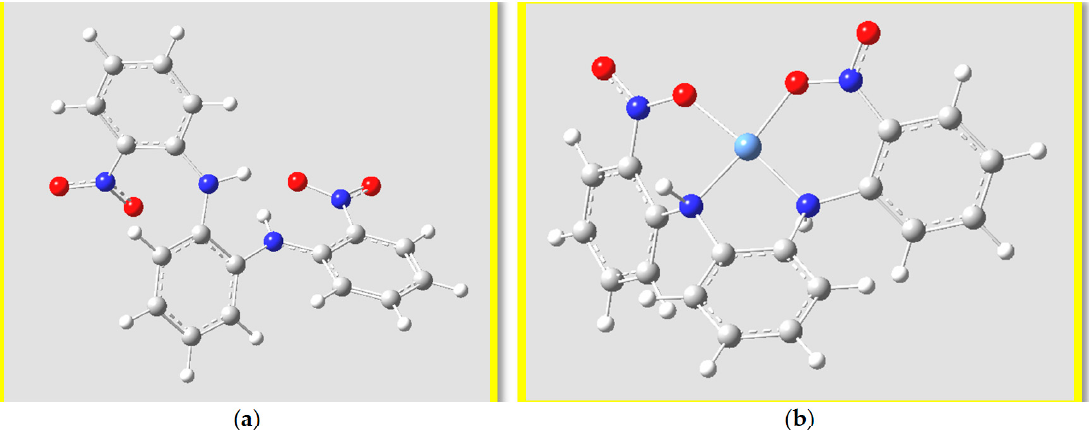
Figure 9. DFT optimized structures of TPA ( a ) and TPA-Ni 2+ complex ( b ). White, red, dark blue, grey and light blue spheres refer to H, O, N, C, and Ni 2+ , respectively.